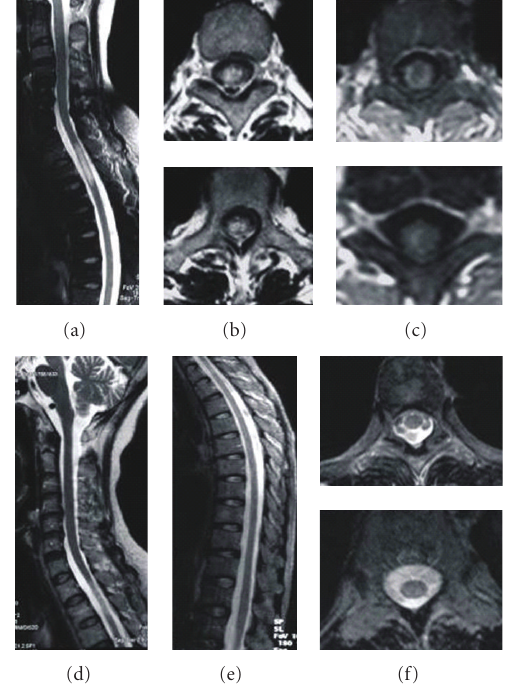
Figure 3: A 58-year-old female developed paraplegia and paresthe- sias in August 2007; weakness slowly worsened. Pulse methylpred- nisolone and IVIG were initiated with no resolution; she continued to deteriorate. After 2-year ATT, her situation fully recovered. The MRI changes are as follows: (a) sagittal T2-weighted image showing a contiguous area of increased signal intensity spanning T2 to T3 level, (b) axialT2-weighted imagesreveal the strong signals,(c) axial MRI images showing focal cord enhancement, (d) after 5 months of ATT, the lesion decreased, (e) following 1-year ATT, sagittal T2- weighted MRI of the thoracic cord reveals no abnormal signals, and (f) no lesion is visible on cross-sectional T2-weighted